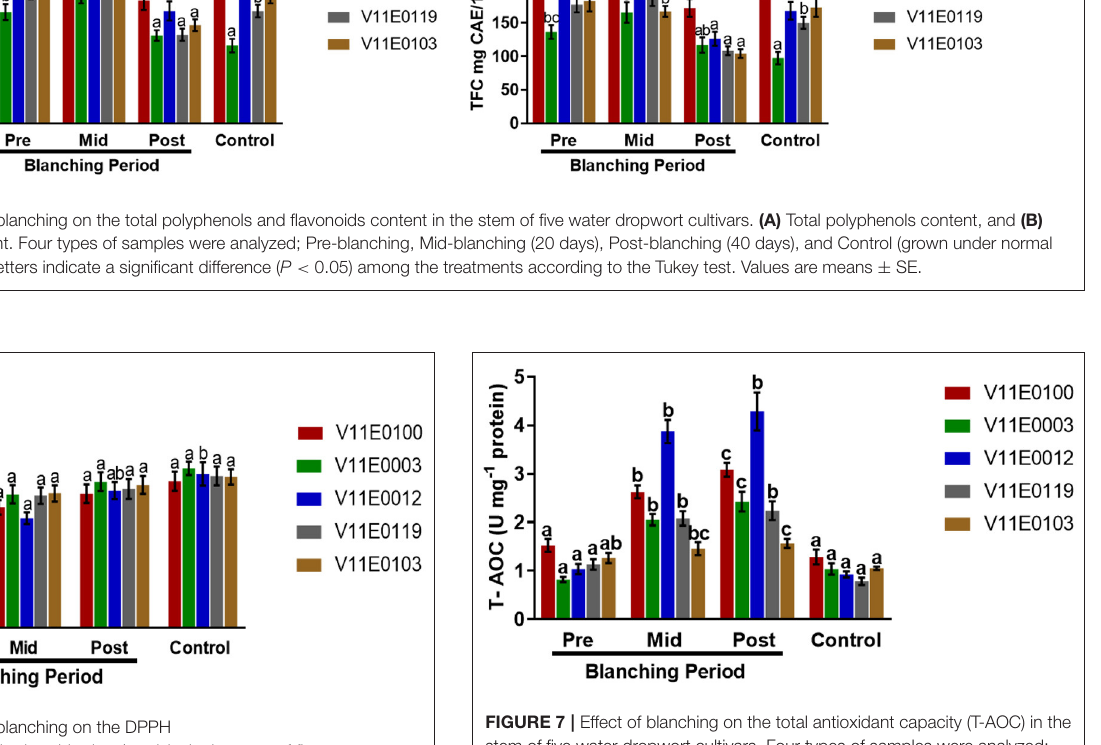
V11E0003, V11E0012, and V11E0119 showed lower vitamin C contents than their pre-blanching samples ( Figure 8D